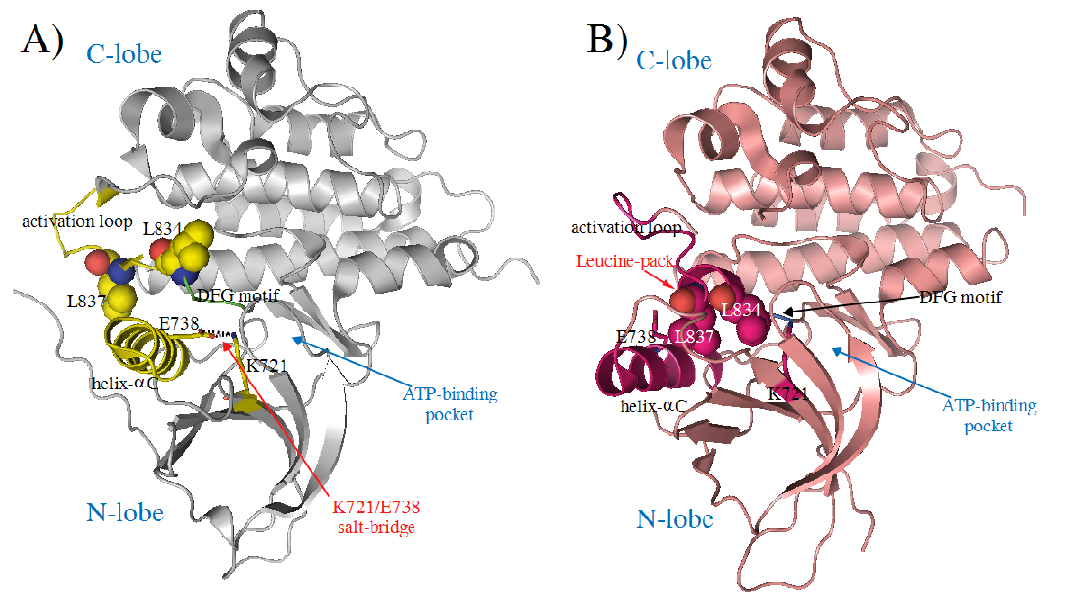
Figure 2. The ribbon presentation of EGFR-TK structures in the active conformation (A) and the inactive conformation (B). Both structures are different in the arrangement of the activation loop (A-loop) and the orientation of the helix- α